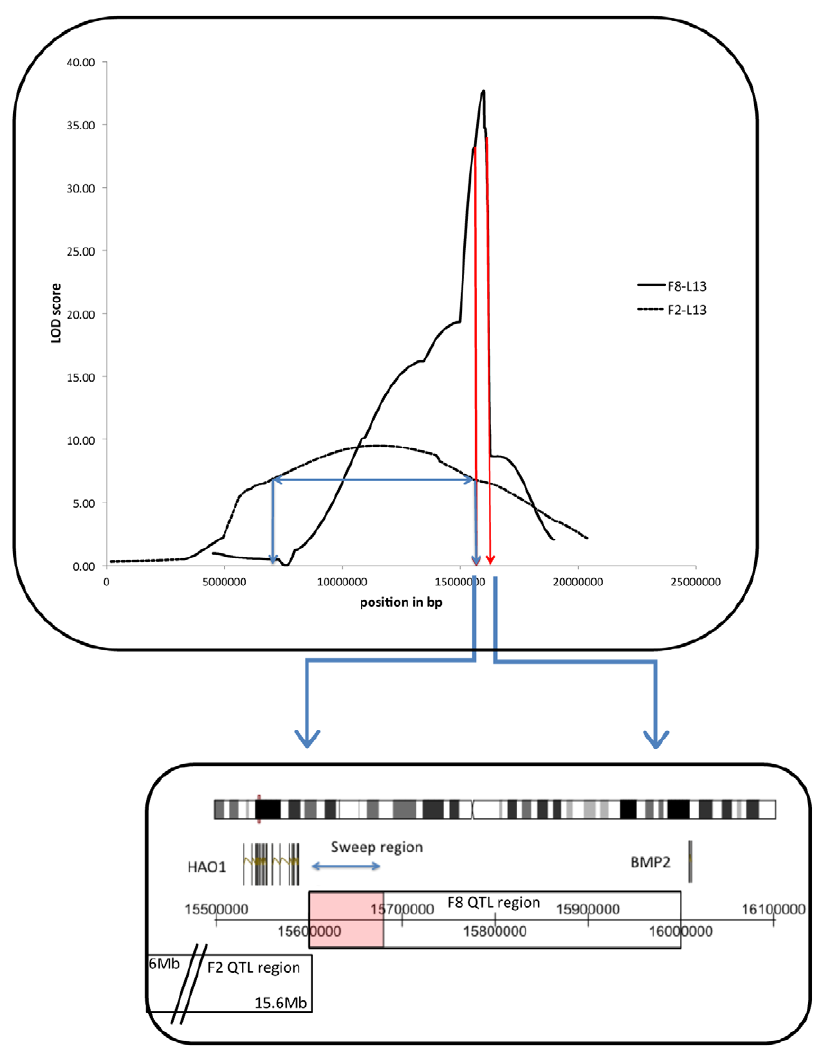
Figure 2. Chromosome 3 QTL peaks and confidence intervals (C.I.) from the F 2 -L13 (blue line) and F 8 -L13 (dark red line) crosses. In the case of the F 2 -L13, the horizontal arrow indicates the 1.8 LOD drop C.I. of the QTL position. The location of the F 8 -L13 C.I. has been expanded below the graph to show the location of the two candidate genes and the selective sweep, and the overlap with the F 2 -L13 C.I.